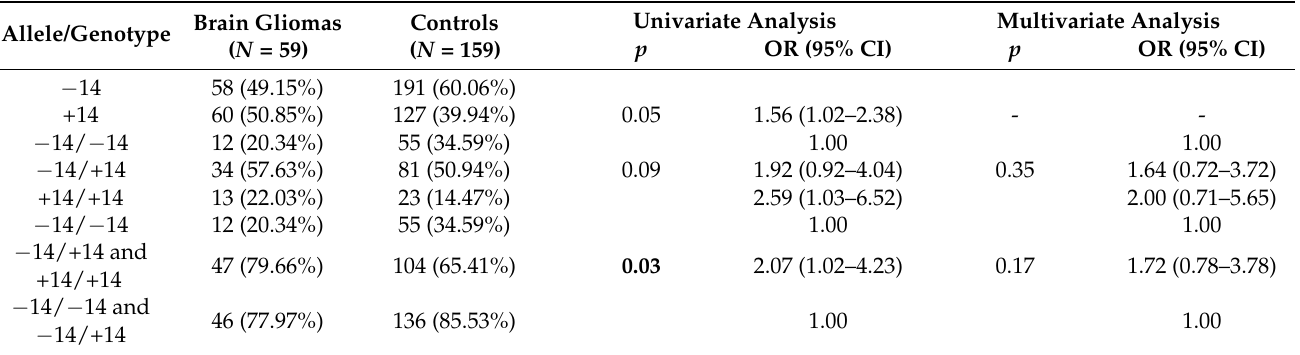
Table 2. Allele and genotype frequencies of HLA-G 14bp ins/del polymorphism in glioma patients and healthy